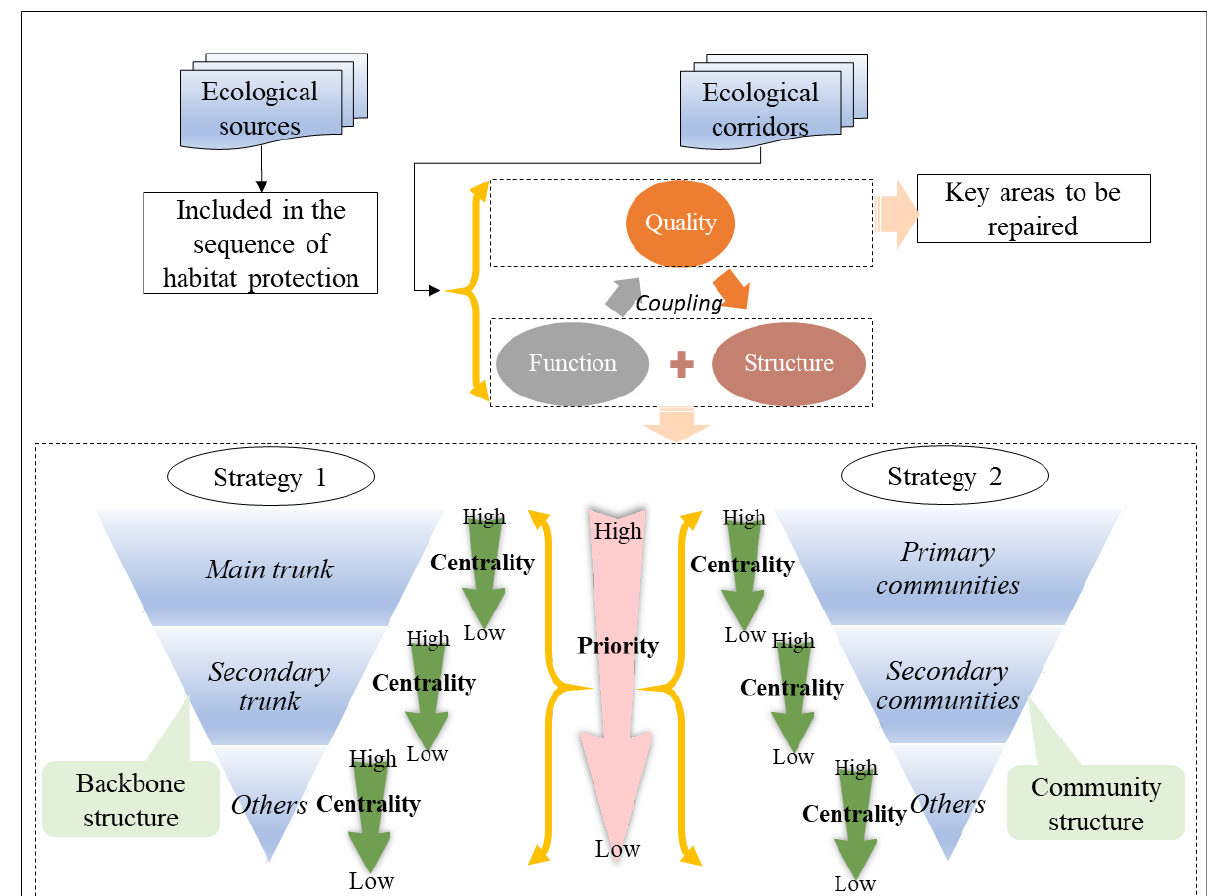
Figure 13. Protection of ENs based on the coupling of “quality–function–structure”.